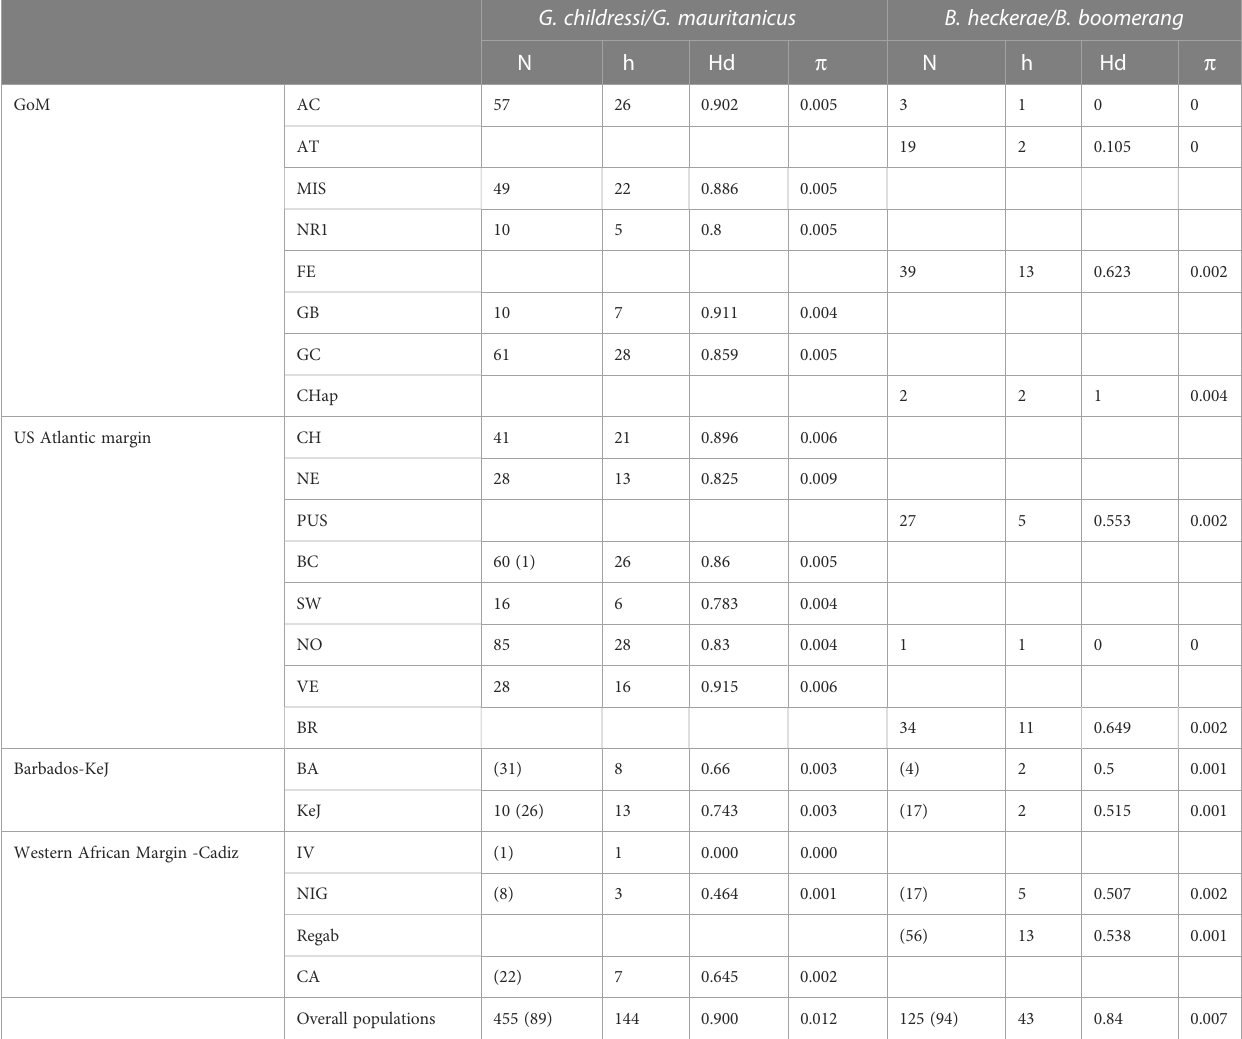
TABLE 4 Variation of COI nucleotides sequences for each species complex and each sampling